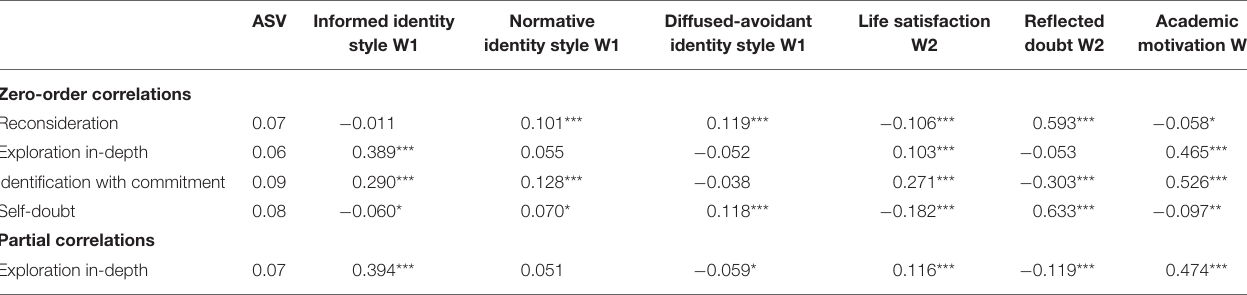
TABLE 5 | Zero-order and partial correlation testing the convergent validity of the post-transition EIPS at